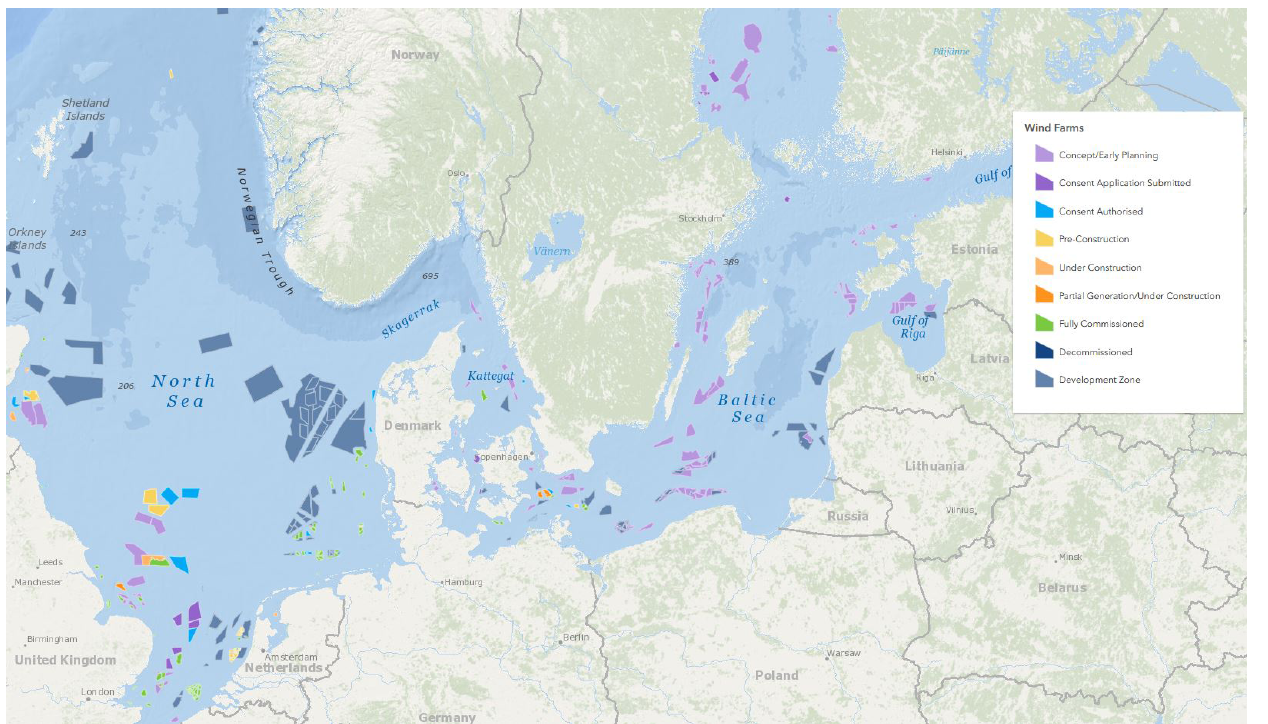
Figure 12. Overview of wind farms in different development states in parts of the Baltic Sea and the North Sea (http://www.4coffshore.com, last access: 9 March 2021, courtesy of